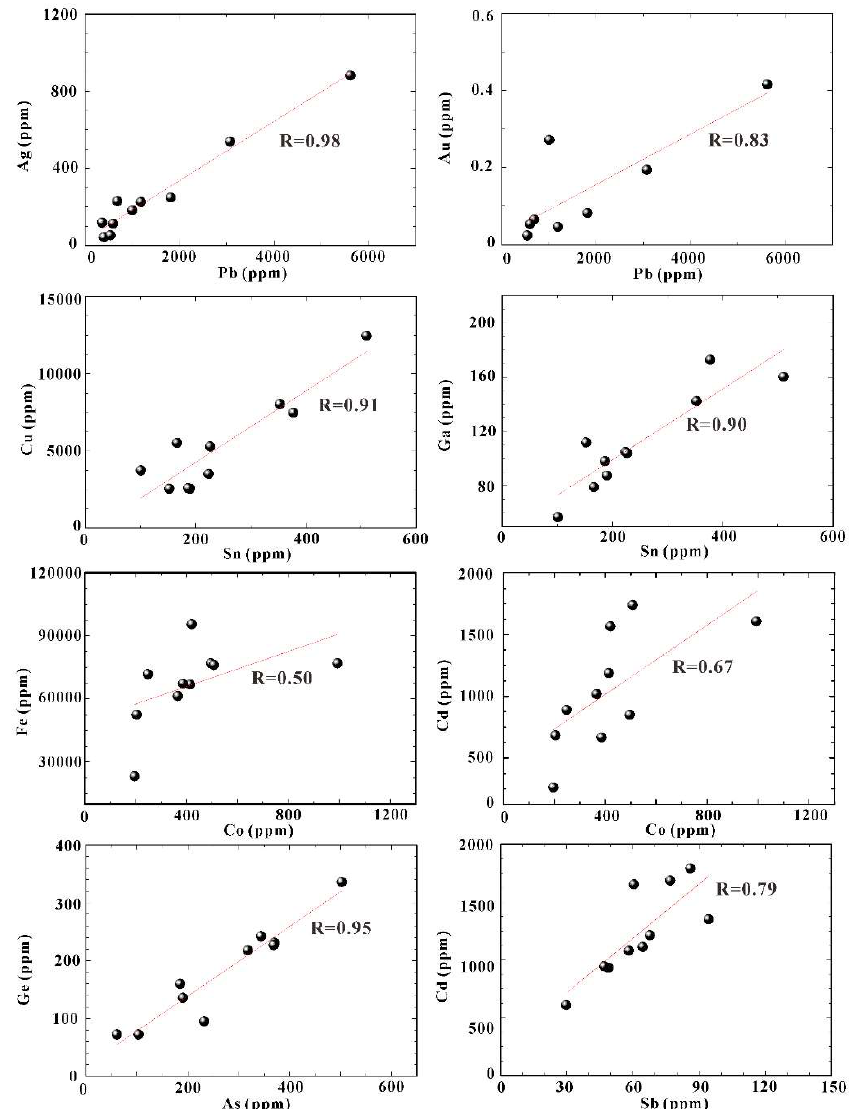
Figure 8. Trace element correlations of sphalerite for Pb–Ag, Pb–Au, Sn–Cu, Sn–Ga, Co–Fe, Co–Cd, As–Ge, and Sb–Cd from Zn-rich chimney samples.